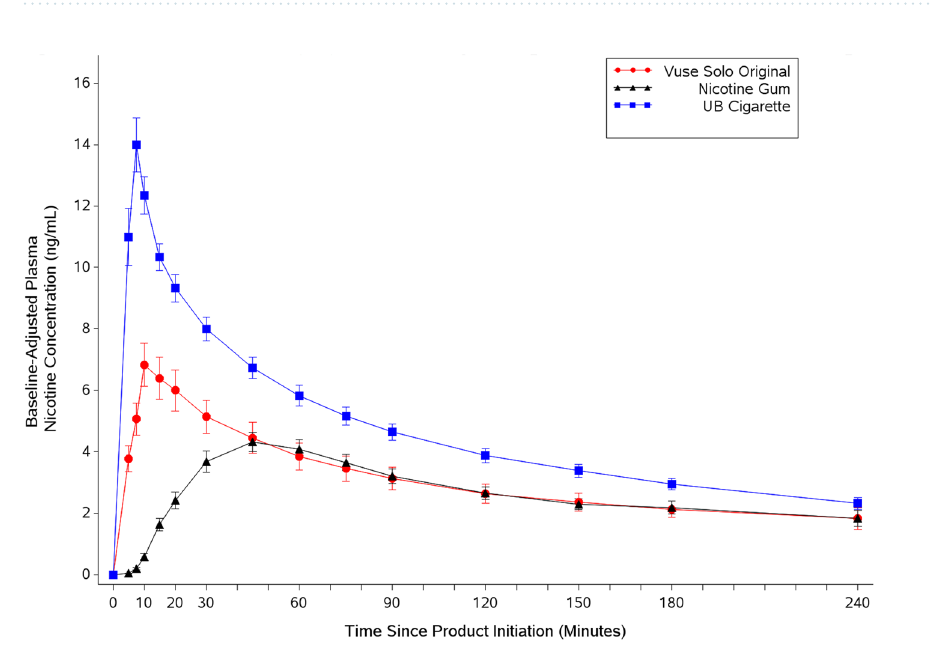
Figure 2. Arithmetic mean (SE) baseline-adjusted plasma nicotine concentration profiles. SE standard error, UB usual